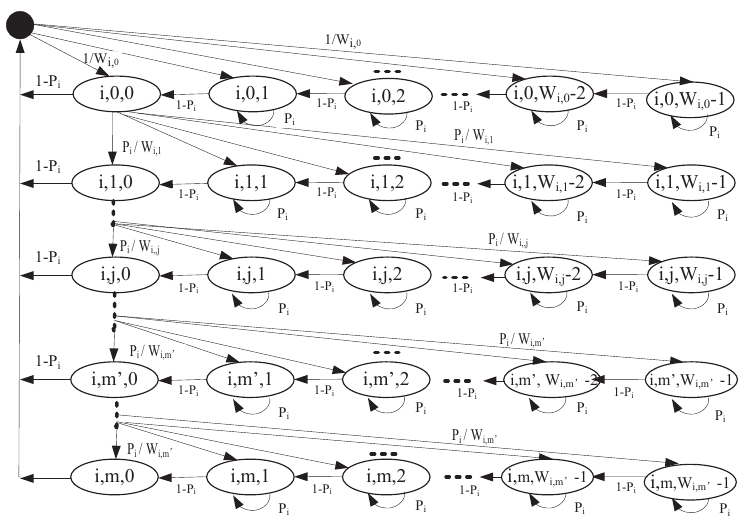
Figure 2. Two-dimensional Markov chain for the priority AC i